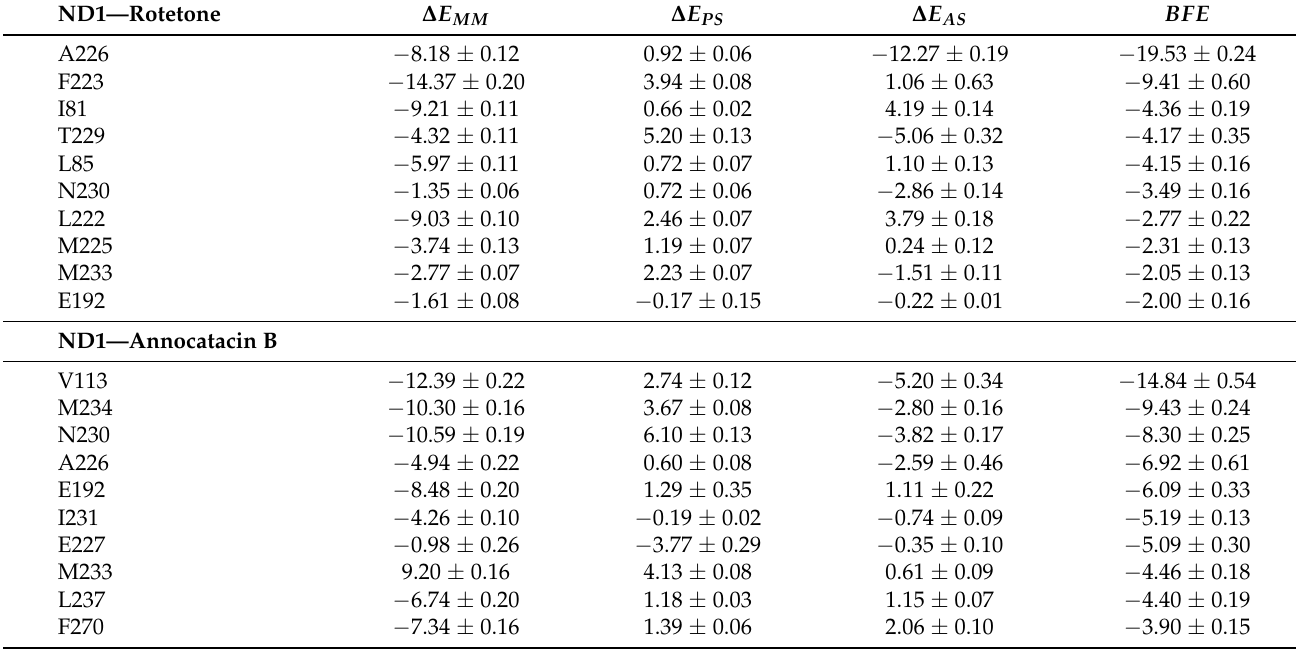
Table 6. Top 10 residues that does contribute to the binding free